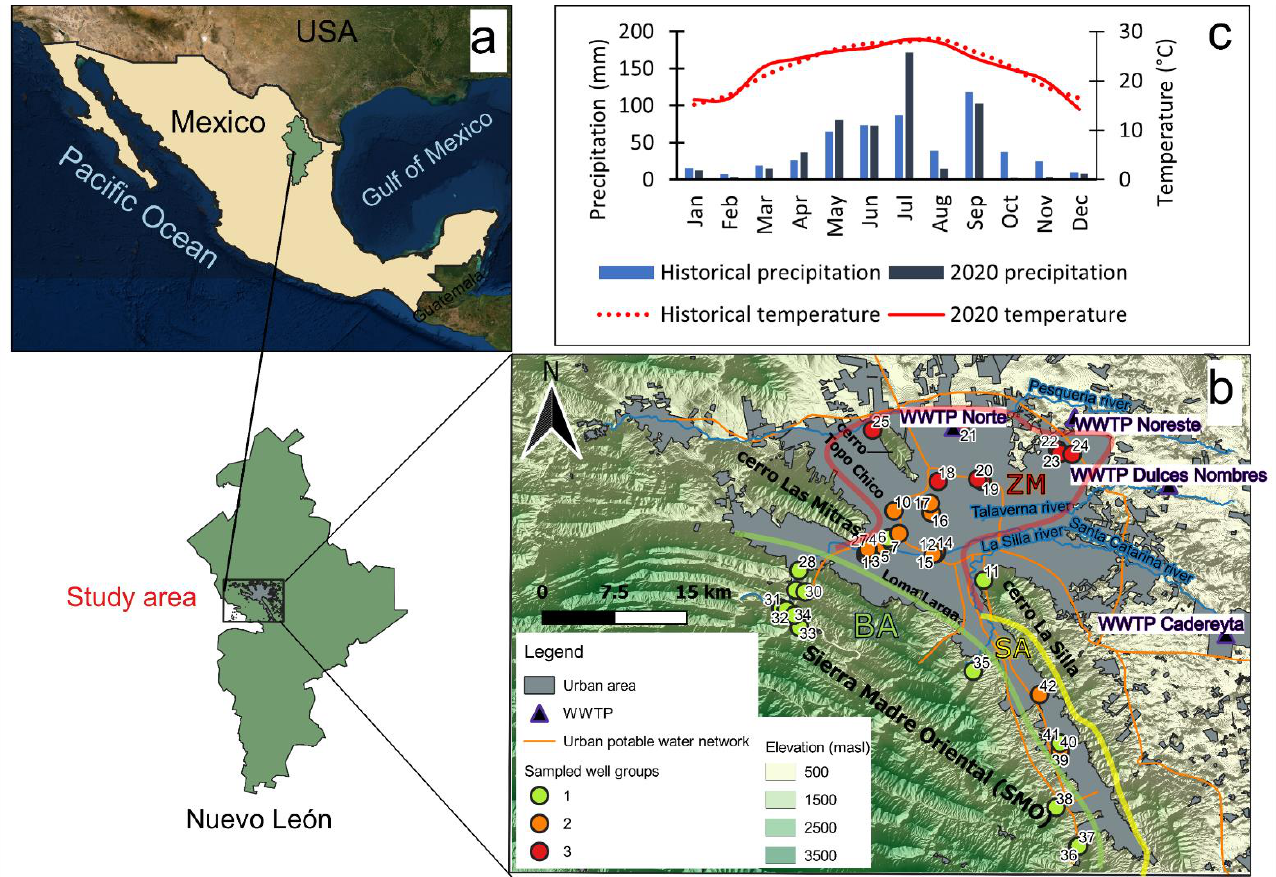
Figure 1. ( a ) Location of the state of Nuevo León in Northern Mexico and the study area, Monterrey Metropolitan Area (MMA); ( b ) location of the sampled wells with well numbers. The different colors indicate well groups identified using the clustering method described in the main text: green indicates recharge zone samples, orange indicates transition zone samples, and red indicates discharge zone samples; ( c ) historical (1951–2020) and 2020 accumulated monthly precipitation and mean monthly temperature in the MMA (source: http://clicom-mex.cicese.mx/ (accessed on 12 March